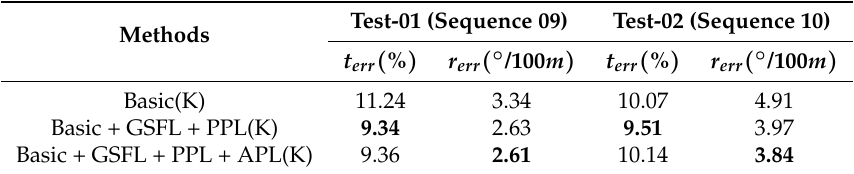
Table 6. The ego-motion estimation ablation experiments are carried out on the KITTI odometry dataset. GSF, PPL, and APL respectively represent the ground self-learning loss, the plane photometric loss and the depth abnormal punishment loss.